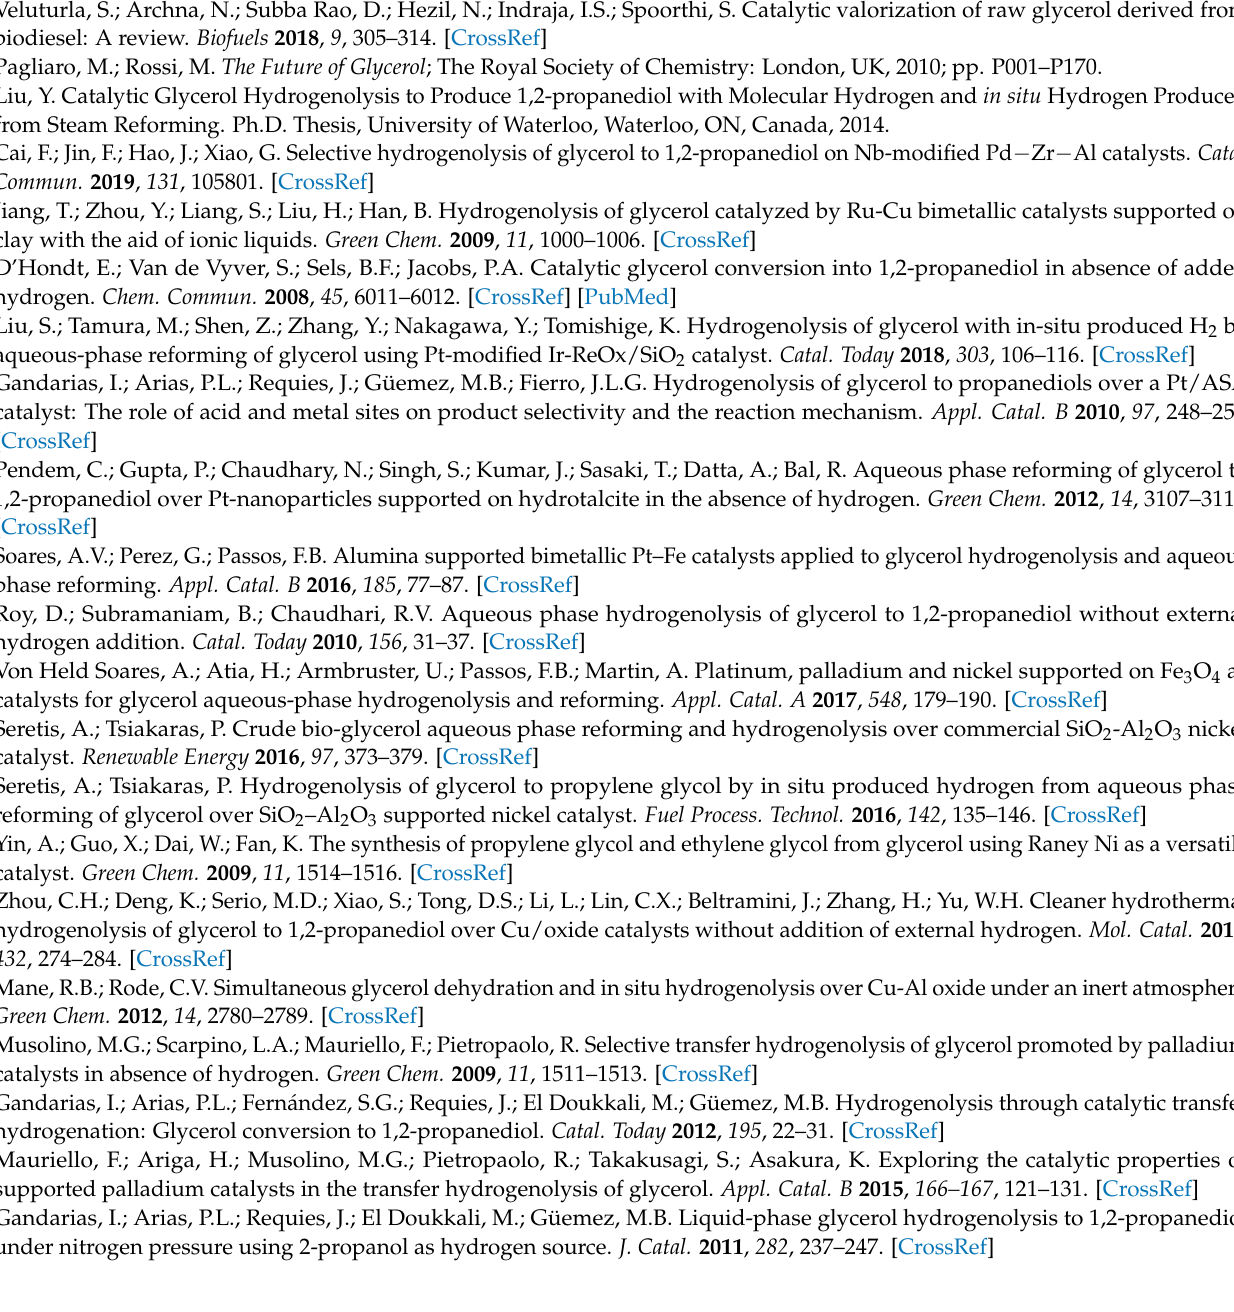
The activation energies for glycerol dehydration and EG formation were estimated to be 104.85kJ/mol and 108.97kJ/mol respectively suggesting that these two reactions were highly temperature dependent. The activation energy of acetol hydrogenation was esti- mated to be 18.81kJ/mol which is significantly lower than glycerol dehydration suggesting that the acetol hydrogenation is less temperature dependent than glycerol